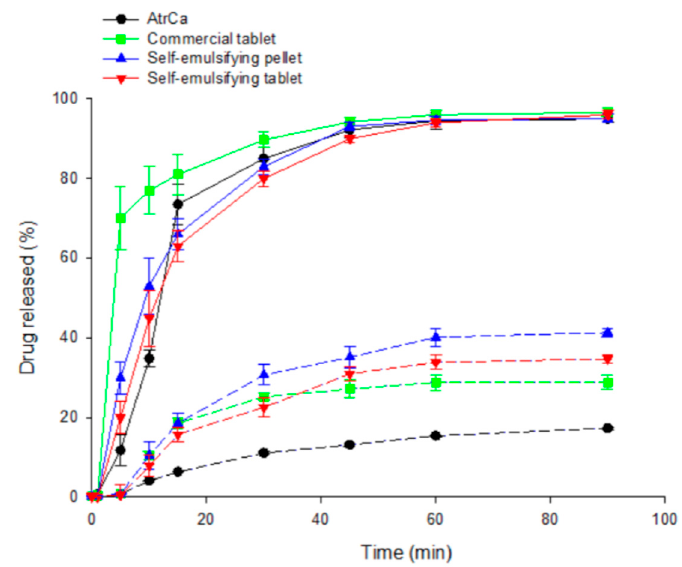
Figure 11. Drug release from unprocessed powder (circles), commercial tablets (square), self-emulsifying pellets (triangles), and self-emulsifying tablets (inverse triangles) at pH 1.2 (broken lines) and pH 6.8 (solid lines).